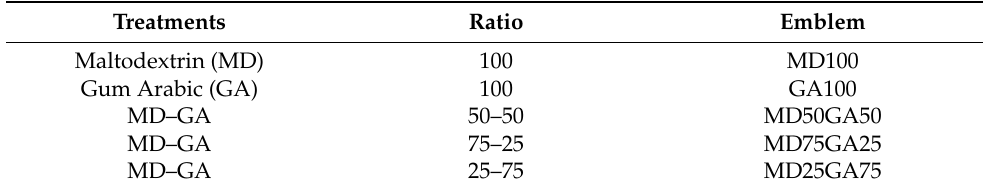
Table 1. Wall material types and ratio.